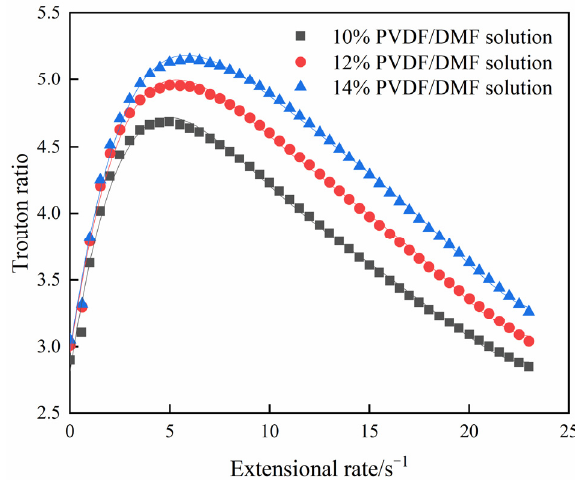
Figure 8. Trouton ratio versus extension rate.